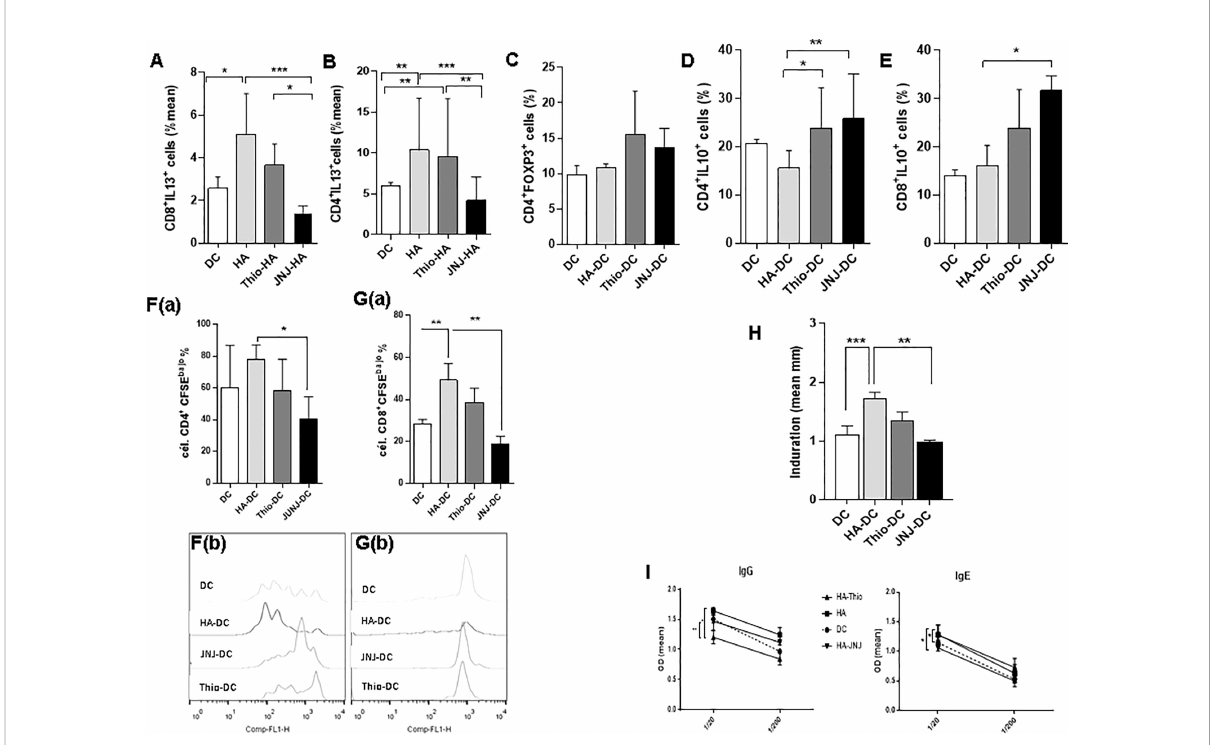
FIGURE 7 Blockade of signaling by blocking the H 4 R on DCs results in a tolerogenic pro fi le. (A, B) The intracytoplasmic content of IL-13 is shown. Lymphocytes from draining lymph nodes were cultured for 24 hours with PMA (10 ng/ml) + ionomycin (1 ng/ml), with the addition of brefeldin A (10 µg/ml). Finally, cells were permeabilized and stained (C) FOXp3 + CD4 + regulatory T cells stained from the draining lymph nodes of treated mice. Cells were permeabilized, then stained with the corresponding antibodies and analyzed by cytometry ( n = 6). (D, E) IL-10 intracytoplasmic determination in lymphocytes cultured for 18 hours with PMA (10 ng/ml) + ionomycin (1 ng/ml), with the addition of brefeldin (10 µg/ml). Finally, cells were permeabilized, labeled, and analyzed by cytometry ( n = 6). ( F, G , panel a) Proliferation of leukocytes from the lymph node is shown. Cells were labeled with the fl uorescent dye CFSE and incubated in plates pretreated with anti-CD3 (0.1 µg/ml). Ninety-six hours later, cells were analyzed by cytometry ( n = 3). A representative experimental histogram is shown for CD4 and CD8 cells ( F, G , panel b). (H) Induration was measured after 9 days of DC treatment. (I) Quanti fi cation of allergen-speci fi c antibodies measured in serum of treated mice ( n = 7). Bars represent the mean ± SEM. * p < 0.05; ** p > 0.01; *** p < 0.001. ANOVA with Tukey ’ s